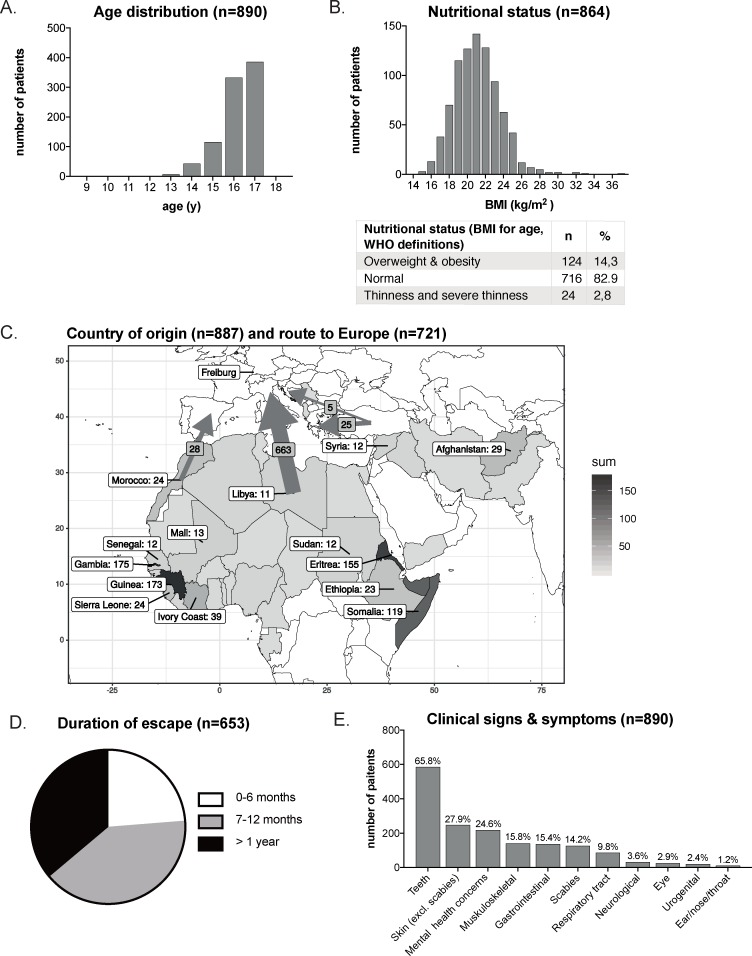
Sociodemographic characteristics of the screened cohort of unaccompanied refugee minors (n = 890).(A) Age distribution; (B) nutritional status; (C) route and (D) duration of migration, as well as country of origin; (E) clinical signs and symptoms. The gray scale indicates the frequency of refugees from a specific country (see legend on the right). The size of the arrow indicates the relative frequency of chosen route to Europe, with the central Mediterranean route being the most important transit route during the study period. BMI, body mass index.